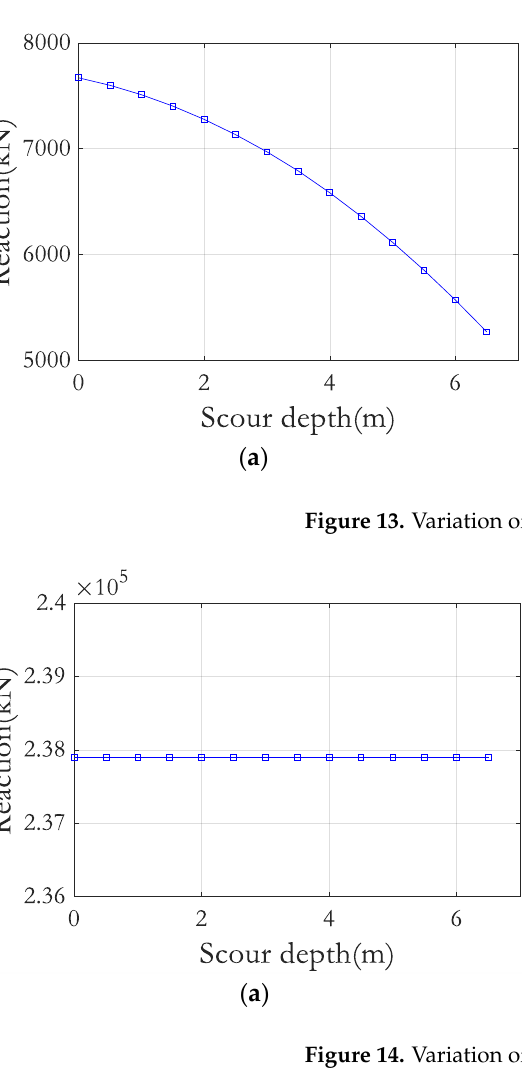
( b ) Figure 15. Variation of horizontal reaction: ( a ) allowable reaction; ( b ) reaction at at SD = 4 m. To see how the safety margin affects the fragility, five cases of safety factors (SFs) were applied to the maximum horizontal reaction force. The fragility curves of the five safety factor cases are shown in Figure 16. The corresponding median and standard devi- ation values of the fragility curves are listed in Table 2. As can be seen from Figure 16 and